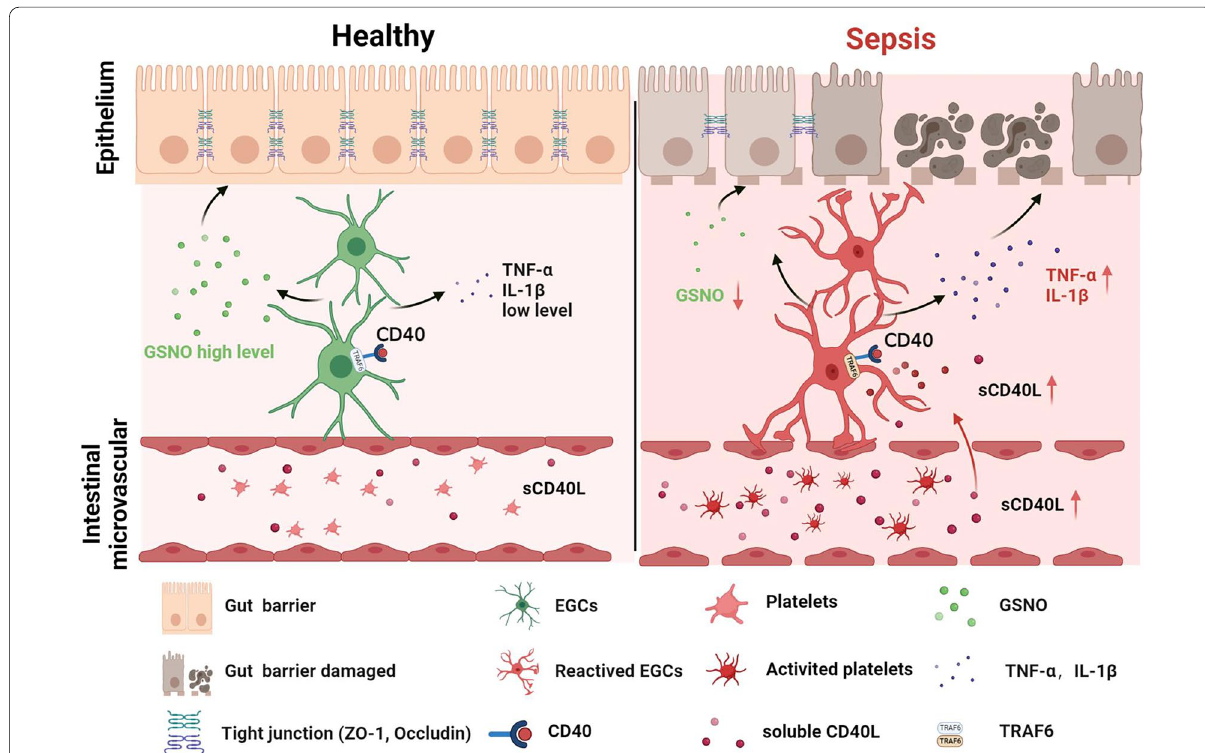
Fig. 7 Graphic summary illustration. Inhibition of platelet activation suppress reactive enteric glia and mitigated intestinal barrier dysfunction during sepsis, which is associated with CD40L-CD40 signaling